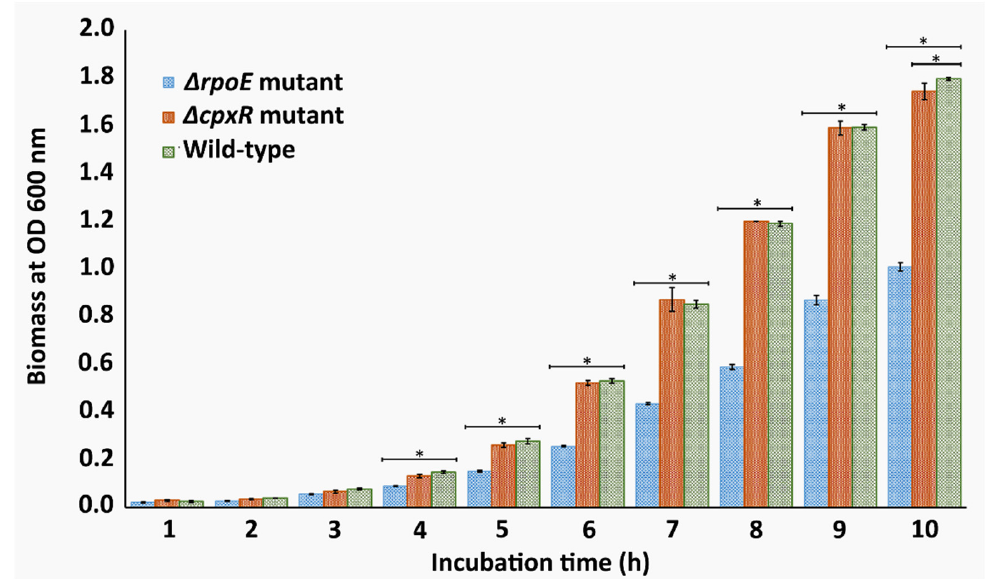
Figure 1. Evaluation of the effects of cpxR and rpoE deletions on the growth kinetics of S. enteritidis during the exponential and early stationary growth phases. Seed cultures were diluted 100 folds and incubated at 22 °C with permanent shaking at 190 rpm. The growth of cultures was measured using optical density at 600 nm for every 60-min during the 10-h period. The error bars indicate the standard errors of the means ( n = 3). Asterisks (*) represent statistically significant differences ( p < 0.05). Data are averages of three biological replications .